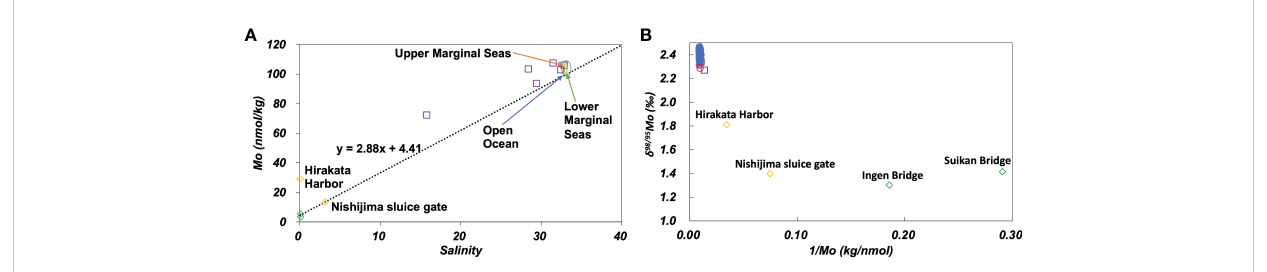
FIGURE 5 (A) : Mo concentration plotted against salinity. The dotted line passes the average of the Uji River and the average of the open ocean. (B) : d 98/95 Mo plotted against the inverse Mo concentration. Green diamonds: the Uji River, yellow diamonds: the Yodo River, purple squares: Osaka Bay, blue circles: the open ocean, red circles: marginal seas.